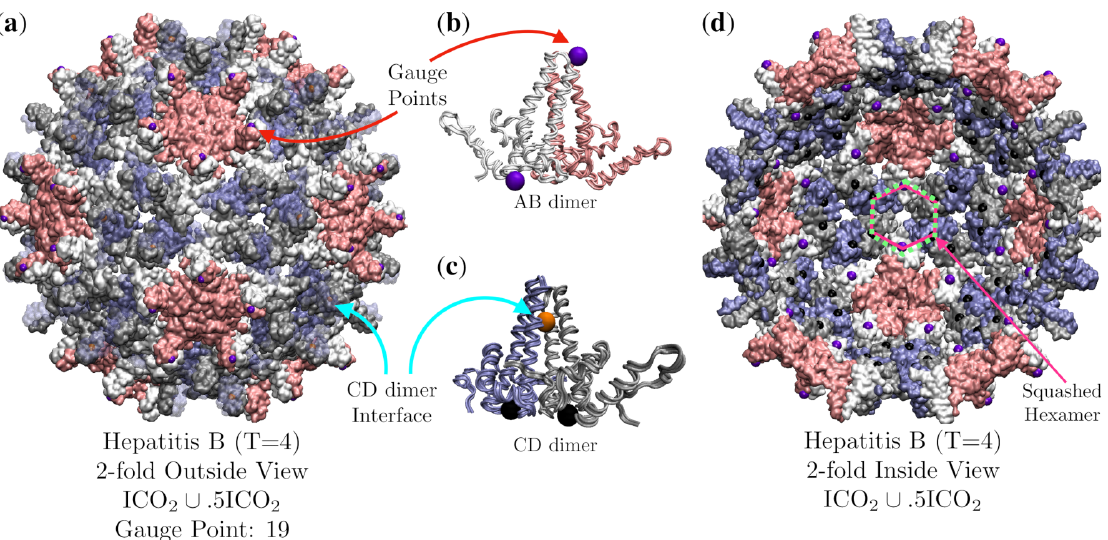
Figure 16. ( a ) A view down the 2-fold axis of Hepatitis B ( T = 4, 1qgt [34]) which is composed of 120 homodimers. The AB dimers (A is pink and B is white) forms the 12 pentamers (pink) and the CD dimer (C is blue and D is gray) along with the B-protein form the 30 hexamer subunits (blue, gray and white). The capsid is best fitted by the double base point array point ICO 2 ∪ .5ICO 2 with an RMSD of 1.3 Å and Gauge Point 19 (purple) located on the AB pentamer dimers. There are also points (orange) located at the internal interface of the CD dimer (Semi-translucent blue proteins for clarity). ( b ) The AB dimer is bounded above (purple) and below (black) by point arrays elements. ( c ) The CD dimer of the hexamers has an orange point on the line of contact between the two α -helices of the CD dimer and rest atop two bulk points (black) on the bottom of each protein of the dimer. The CD dimer is more flexible than the AB dimer [39]. ( d ) Looking out from the interior of the capsid along a 2-fold axis, we see a slightly squashed hexamer (white, gray and blue) centered on 2-fold axis. Each hexamer is in contact with four interior bulk points (black) and two interior 5-2 GC points (purple). As such, the hexamers do not have local 3-fold symmetry, which is consistent with the point array constraints. For comparison, a squashed hexagon is shown as a solid line (pink) and an ideal hexagon is shown as a dotted line (green). Note that even though this point arrays was generated from two base icosahedra ( ICO ∪ .5ICO ) , all of the 5-fold points have been truncated as they are more than 4 Å below the interior